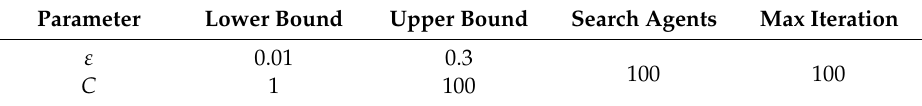
Table 1. The parameters used in the grasshopper optimization algorithm